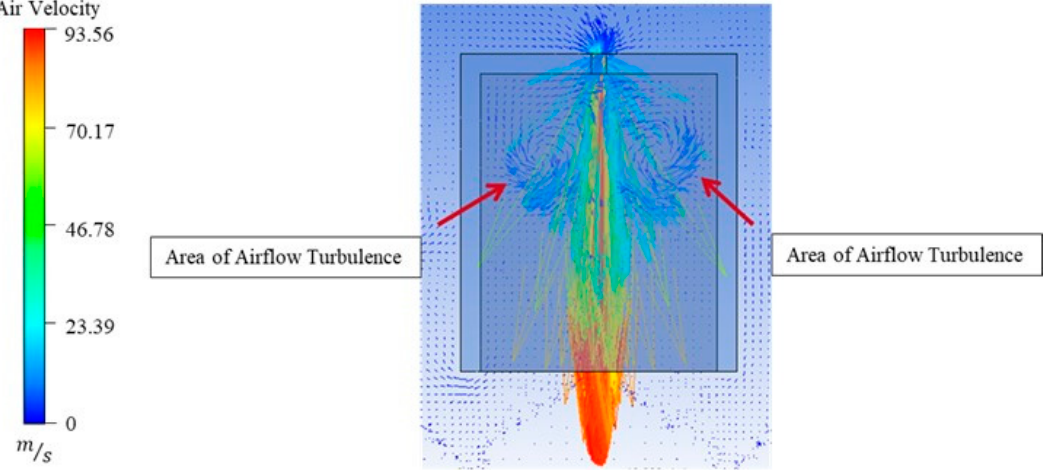
Figure 7. Typical air-flow and vortex variations in the air-chamber of the OWC.